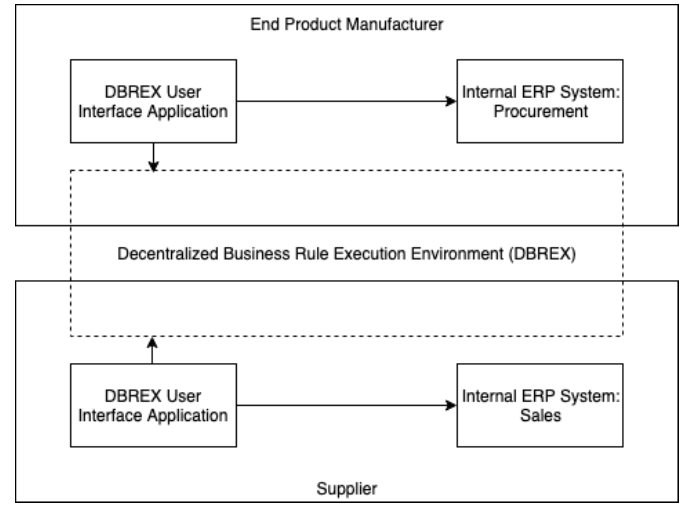
Figure 5. Architecture proposal: Graphical